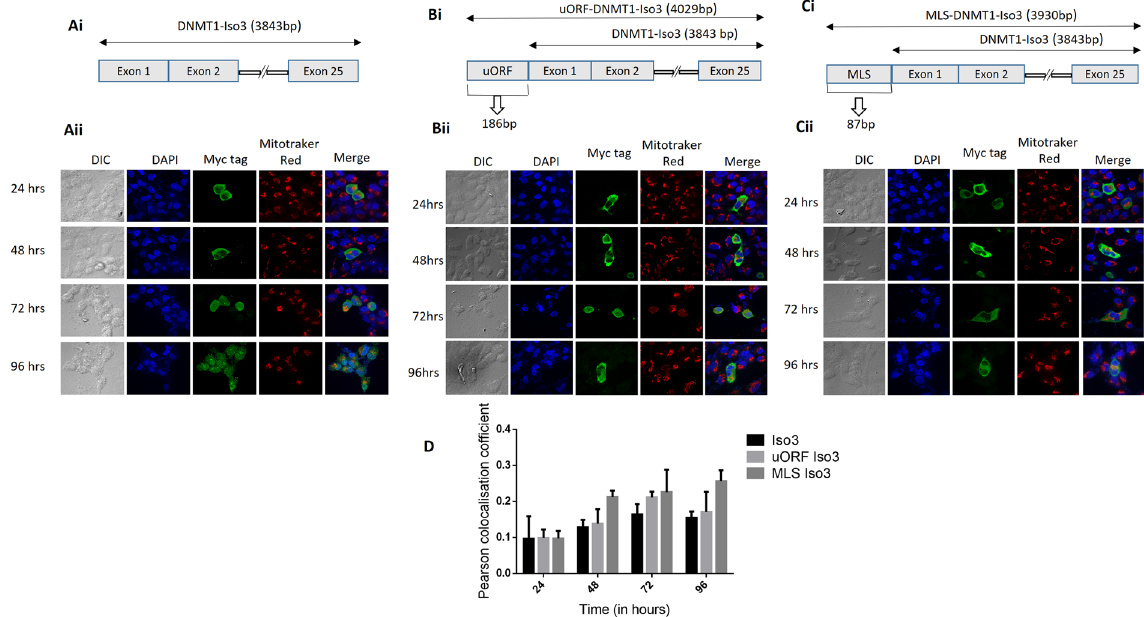
Figure 3. Subcellular localization of DNMT1-isoform3 varies with advancing time period of expression. ( Ai-Ci ) Schematic diagram depicting the structure of: ( Ai ) DNMT1-iso3; ( Bi ) DNMT1-iso3 with uORF; ( Ci ) DNMT1-iso3 with MLS. ( Aii-Cii ) Representative confocal images of H1299 cells showing localization pattern of exogenously overexpressed: ( Aii ) DNMT1-iso3; ( Bii ) DNMT1-iso3 with uORF; ( Cii ) DNMT1-iso3 with MLS at four different time points (24, 48, 72, 96 hrs). ( C ) Pearson co-localization coefficient for mitochondrial localization of DNMT1-iso3, DNMT1-iso3 with uORF and DNMT1-iso3 with MLS.